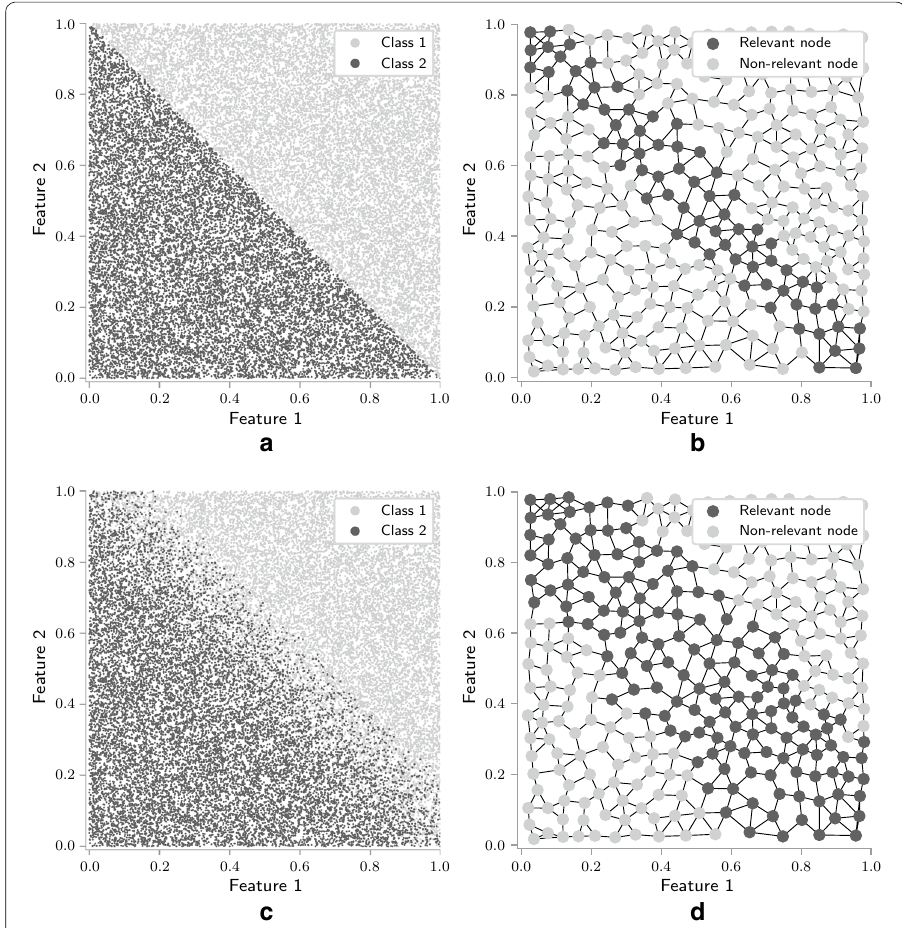
Fig. 7 Reduction of training set. Classification data is more confused in ( c ) compared to ( a ). b , d show cluster nodes that were selected for ( a ) and ( c ) cases, respectively